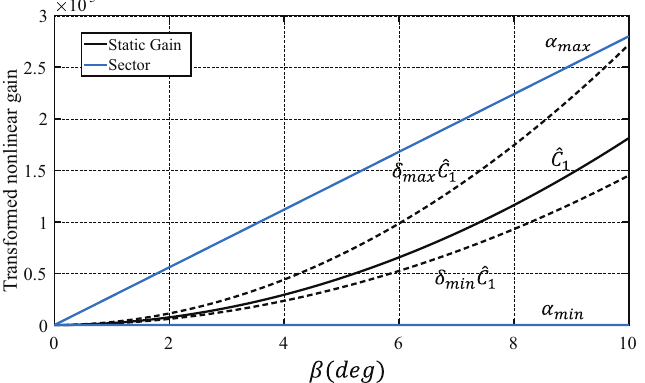
Figure 15. Upper and lower sectors containing the non-linear transformation.